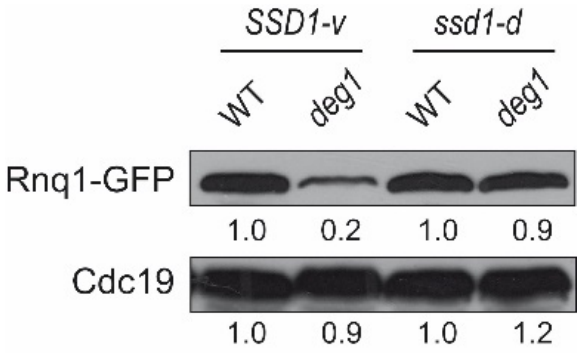
Figure 4. Comparison of protein levels of the glutamine-rich Rnq1-GFP fusion protein in absence of Ψ 38/39 in SSD1-v and ssd1-d backgrounds. The total protein extract from indicated strains expressing Rnq1-GFP was used for Western analysis with anti-GFP and anti-Cdc19 antibodies. GFP and Cdc19 signal intensities were normalized to the respective WT intensity.